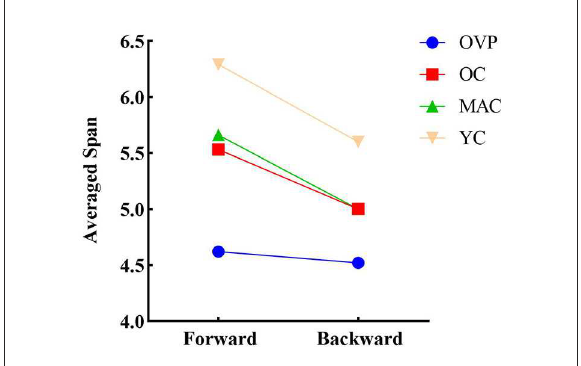
FIGURE3 Differences in recall order of span for individual level. The forward span is significantly longer than the backward span ( p < 0.001). Paired t -test revealed that the difference between recall order in OVP group was not statistically significant ( p = 0.648). OVP, Older vertigo patients; OC, Older controls; MAC, Middle-aged controls; YC, Young controls.